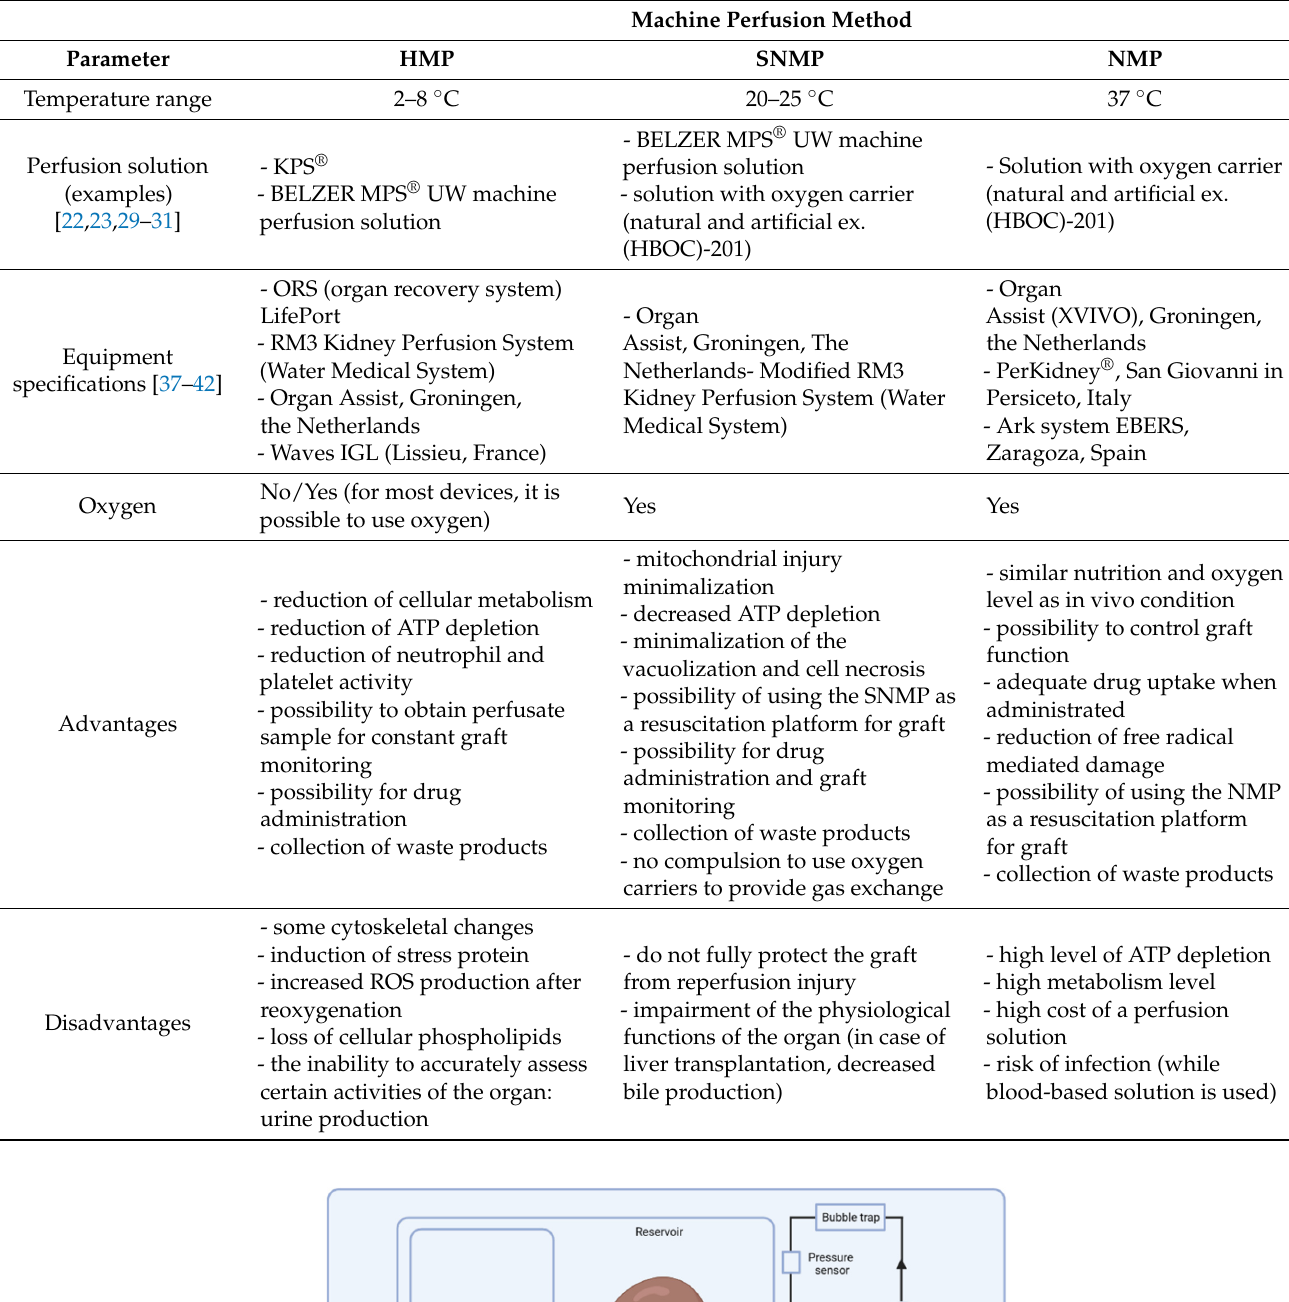
Table 2. Comparison of different machine perfusion techniques. Legend: HMP—hypothermic machine perfusion; SNMP—subnormothermic machine perfusion; NMP—normothermic machine